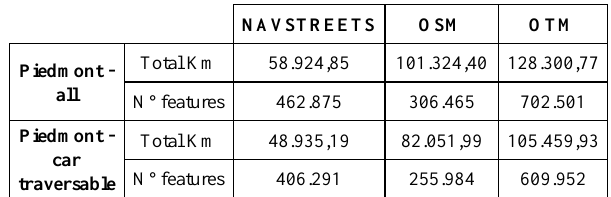
Table 1. Comparison of total km and number of features between OSM, OTM and NAVSTREETS Street Data in Piedmont Region.